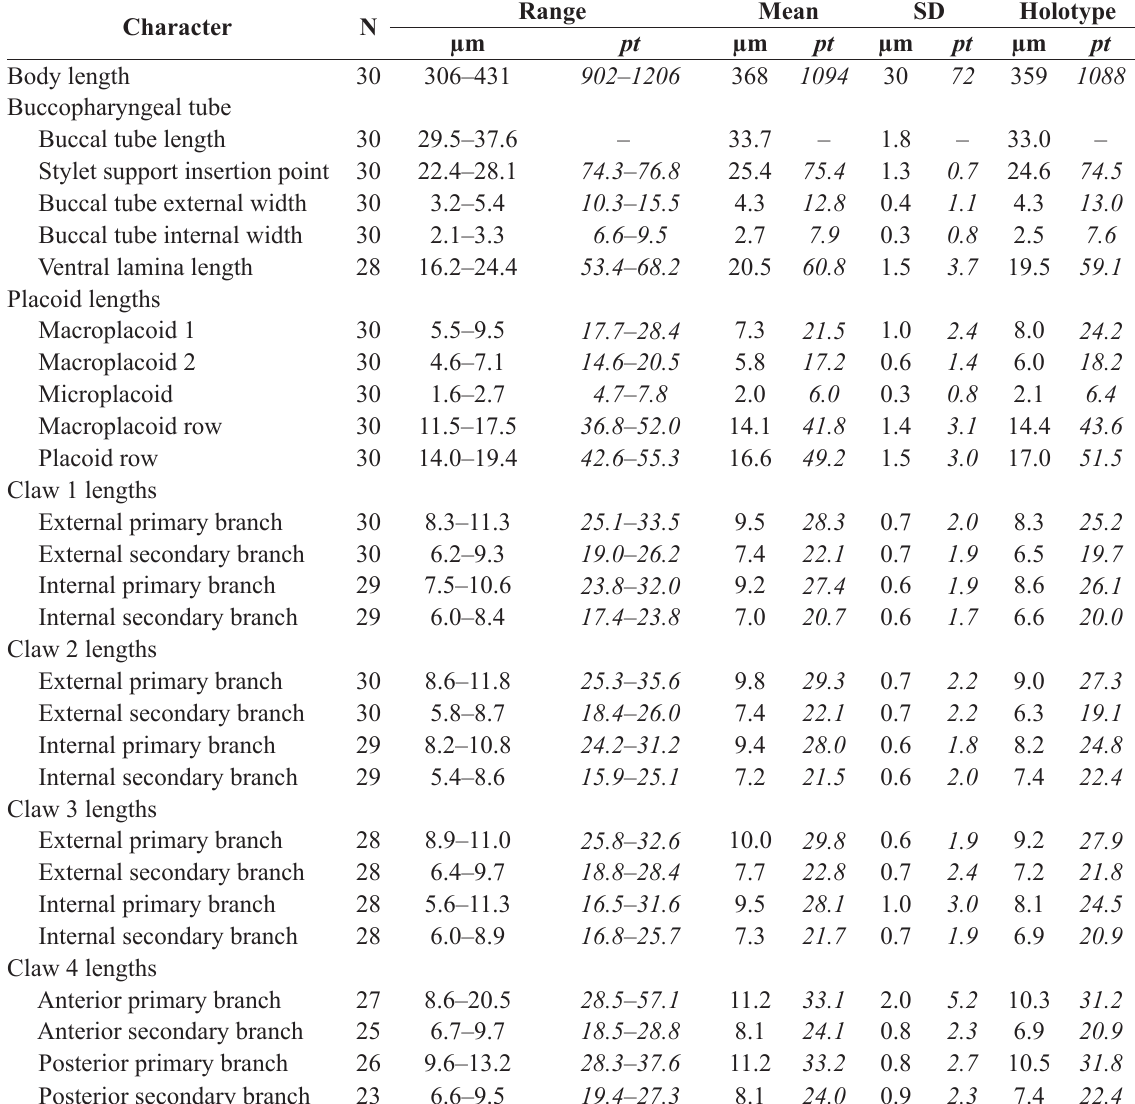
Table 5. Measurements (in µm) of selected morphological structures of individuals of Macrobiotus canaricus sp. nov. mounted in Hoyer’s medium (N = number of specimens / structures measured; Range = the smallest and the largest structure among all measured specimens; SD = standard